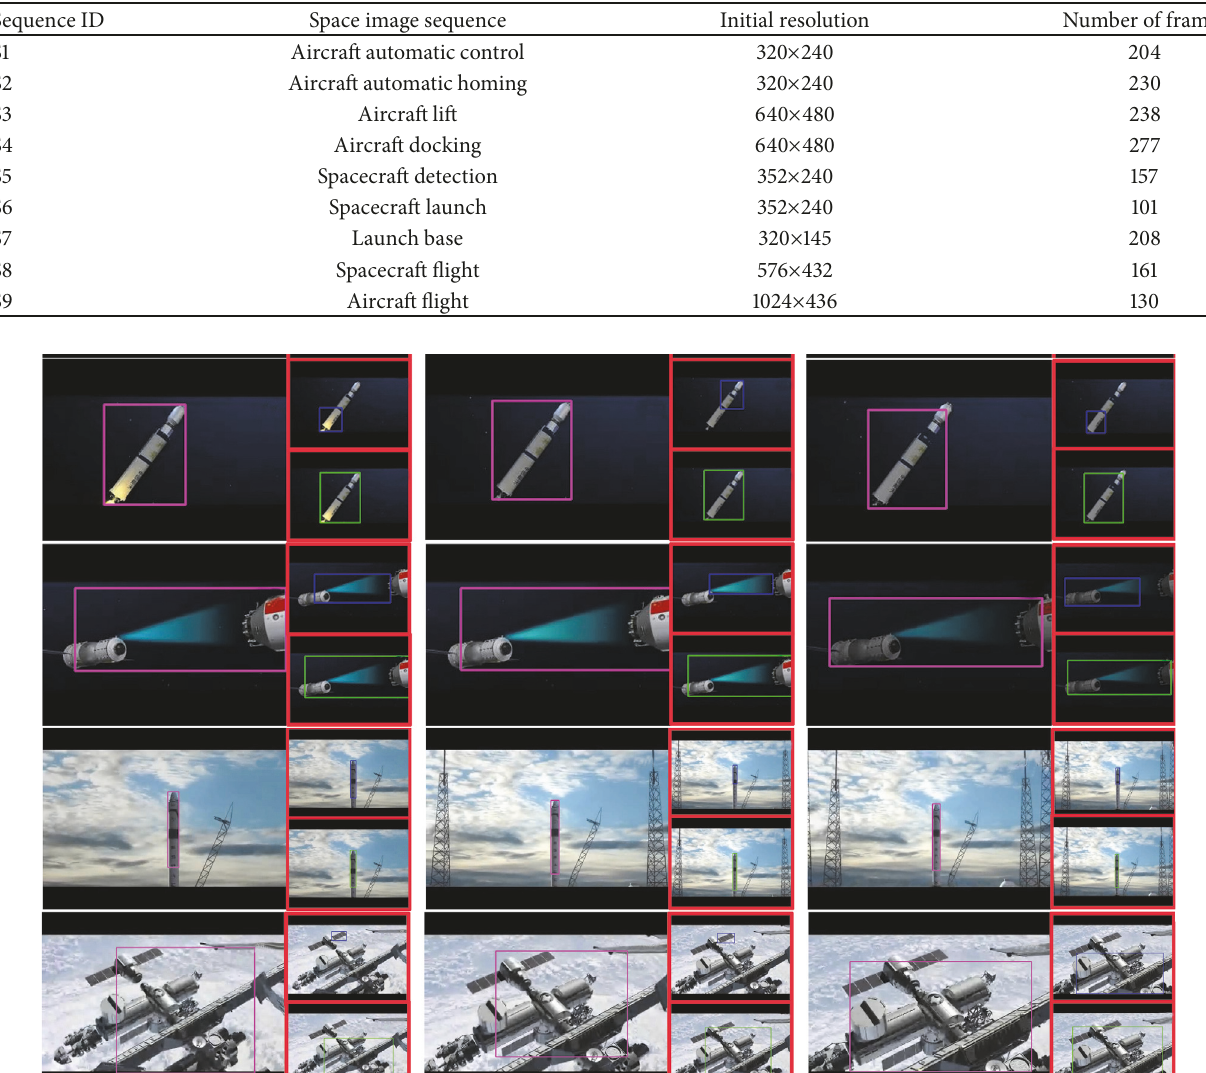
Table 1: Experimental data.